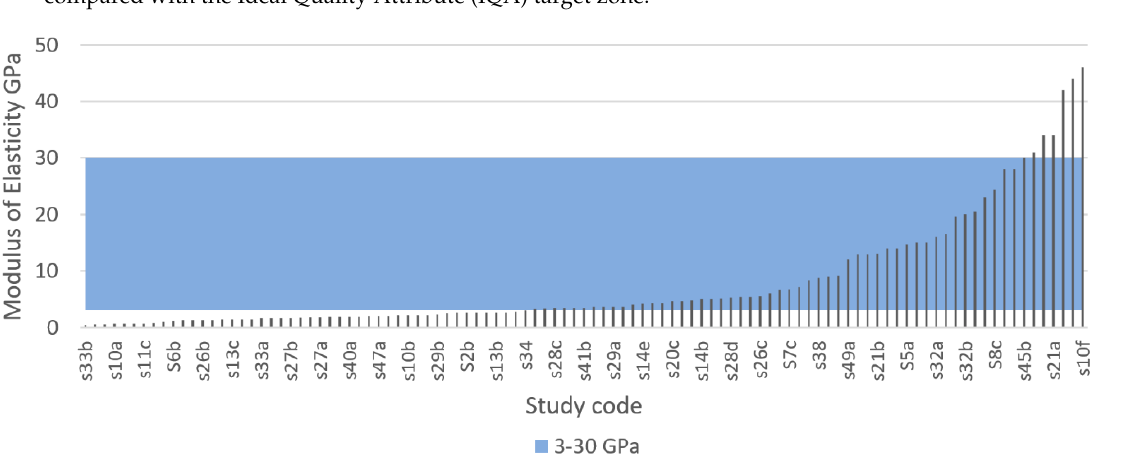
Figure 12. Elastic modulus of porous beam-based metamaterials compared with the Ideal Quality Attribute (IQA) target zone.